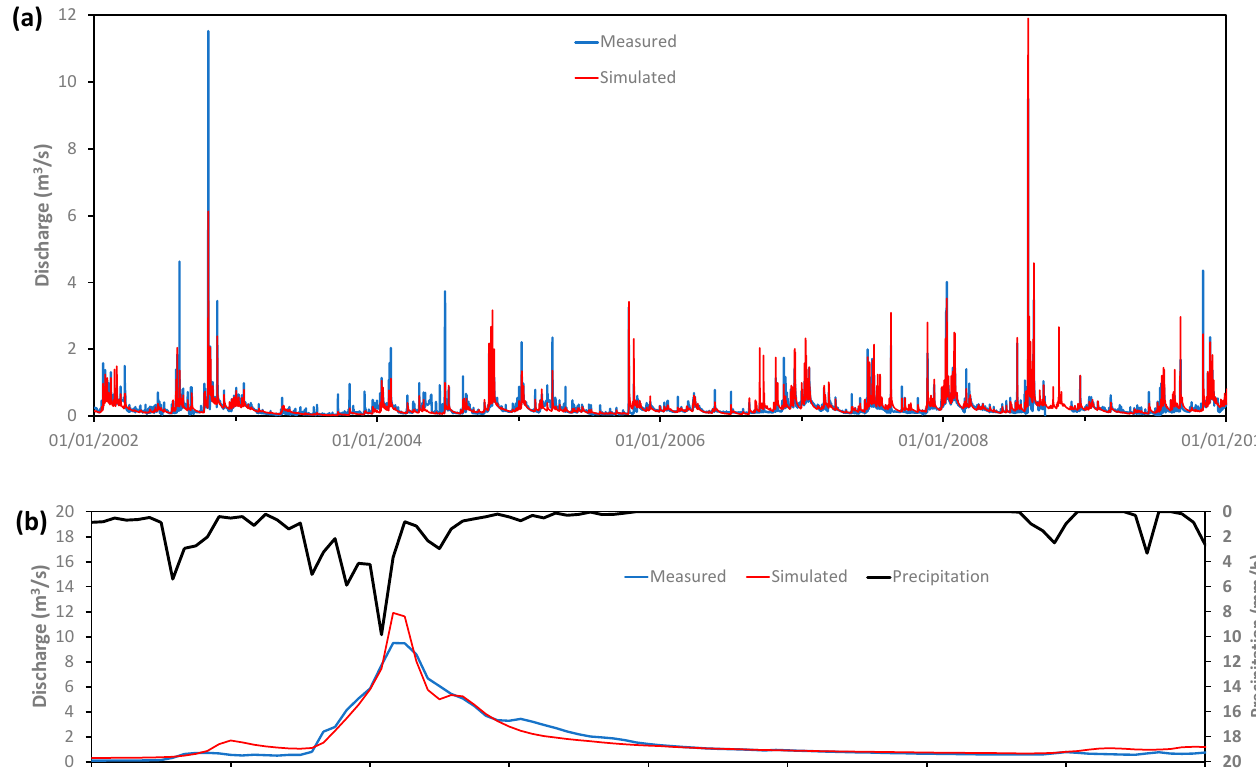
Figure 3. Measured and simulated discharges ( a ) for the 8-year calibration period from 1 January 2002 to 31 December 2009, ( b ) for a 4-day period from 6 August 2008 to 10 August 2008.